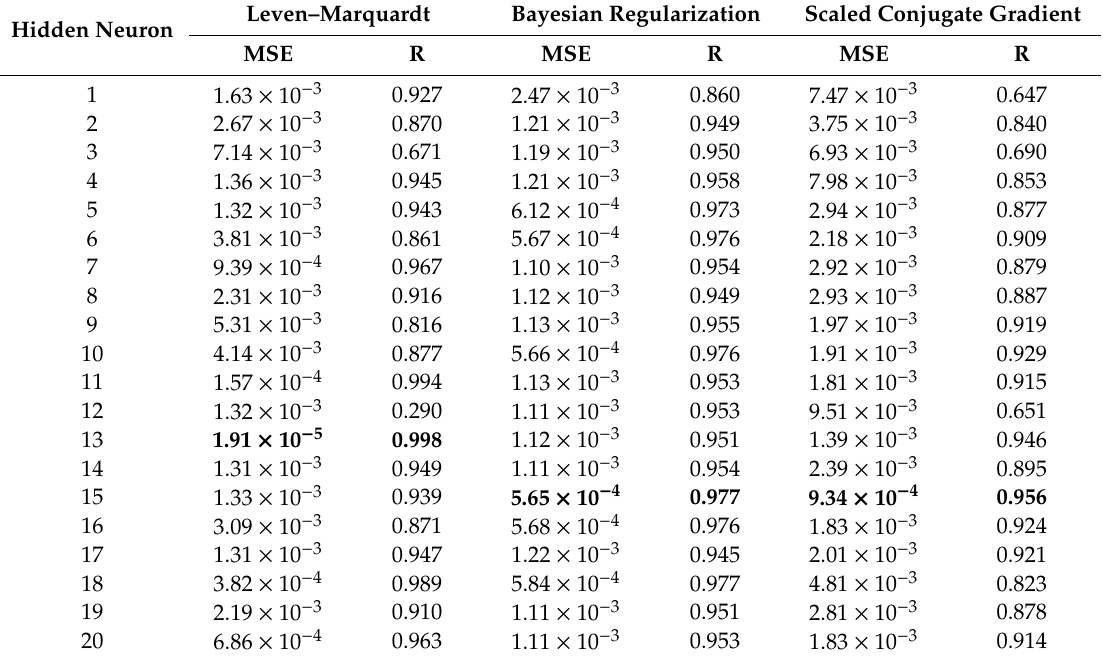
Figure 5. Determination of the optimized hidden neuron with the minimum MSE for ANN training using the scaled conjugate gradient algorithm. Table 2. Determination of the best neuron for each of the training algorithms.